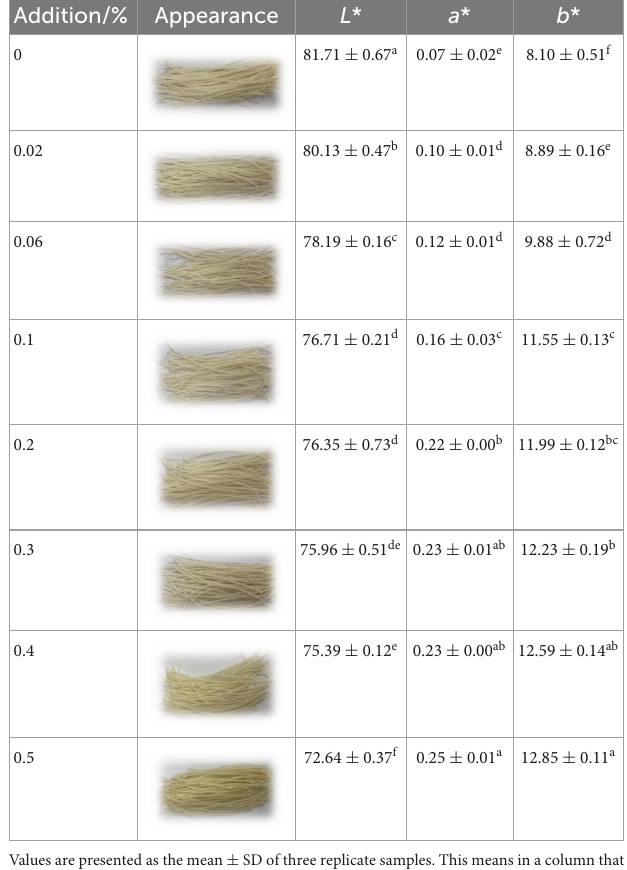
TABLE 5 Effect of sodium bicarbonate on the cooking properties of semi-dried rice noodles. Addition/% Cooked broken